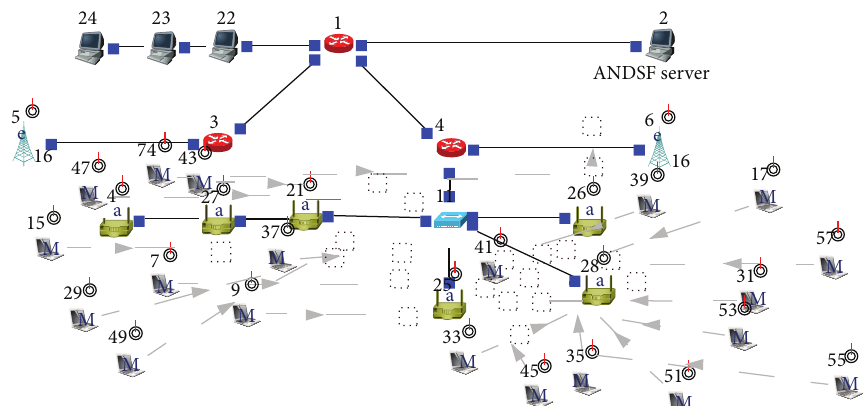
Figure 12: Simulation setup with 20 UEs and 6 APs and 2 WiMAX BSs.